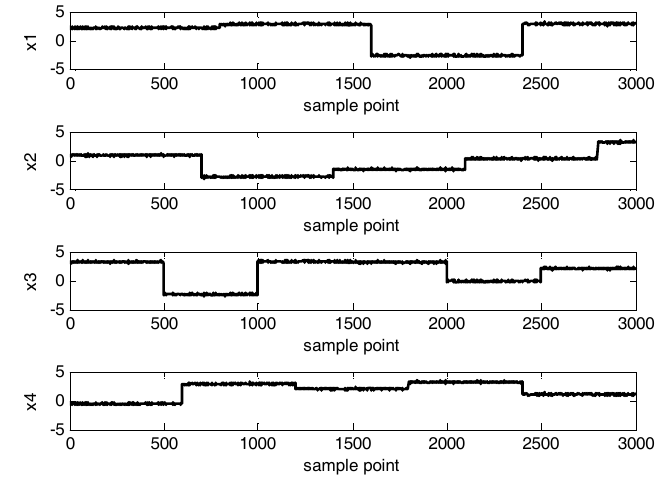
Figure 4. Input data set for polyethylene reaction. Information 2017 , 8 , 121